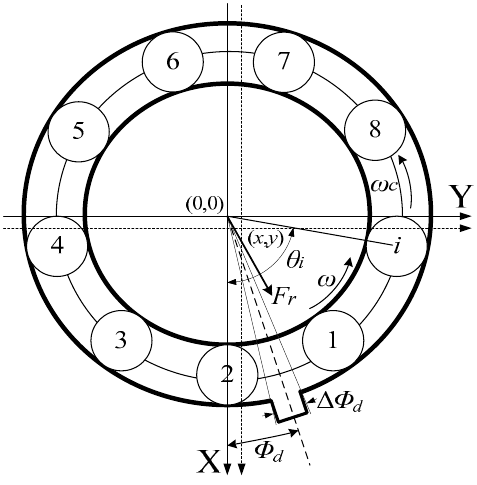
Figure 4. Dynamic model of bearing.